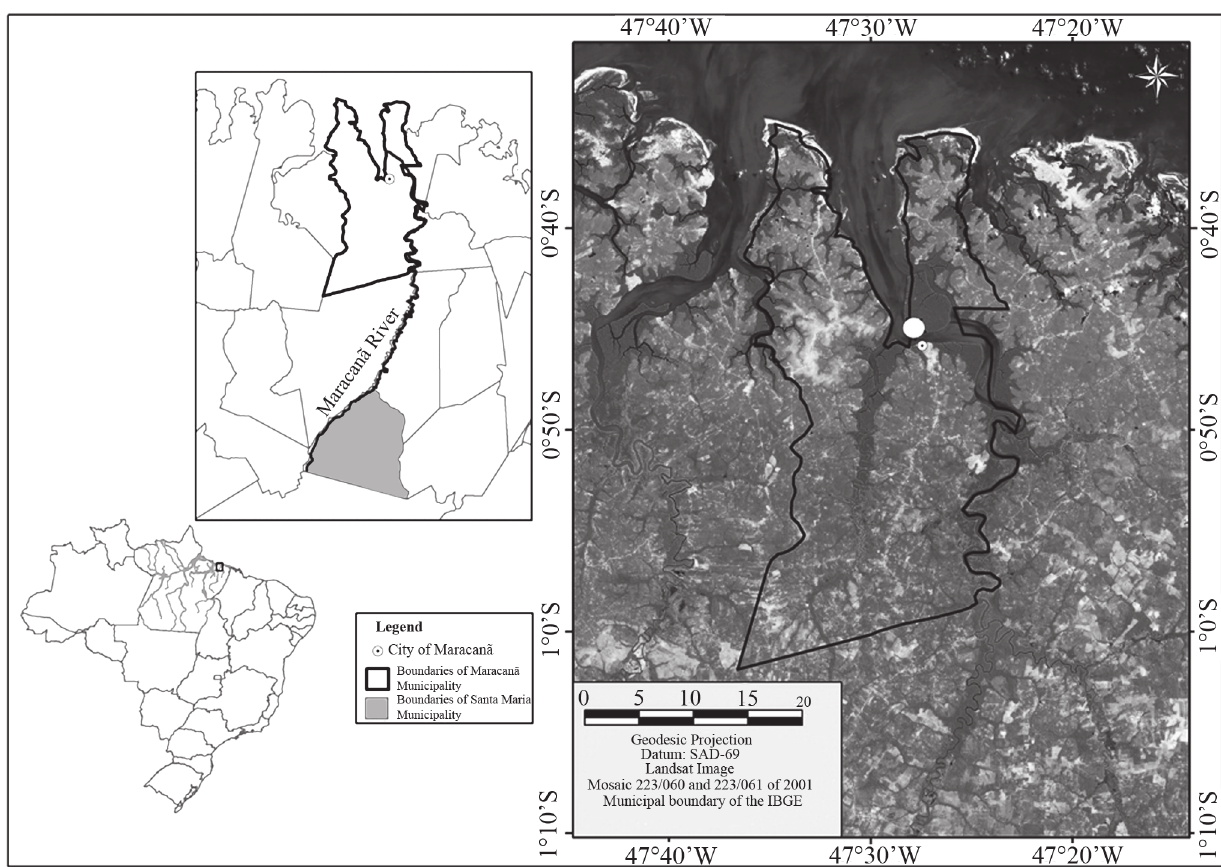
Fig. 1. Study area showing the Maracanã River and the collecting locality (white circle) in the Brazilian state of